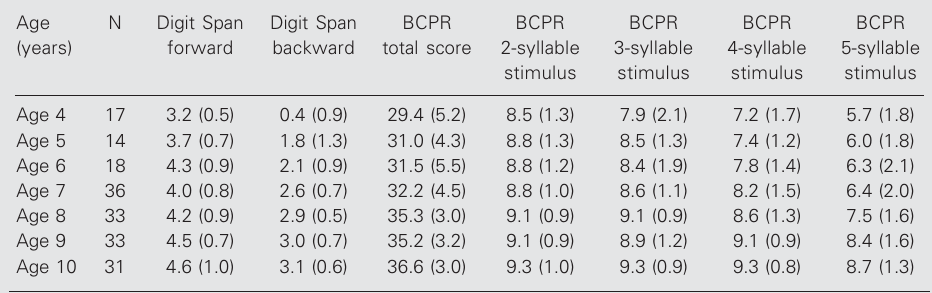
Table 2. Validity study of Digit Span and BCPR by age (N =